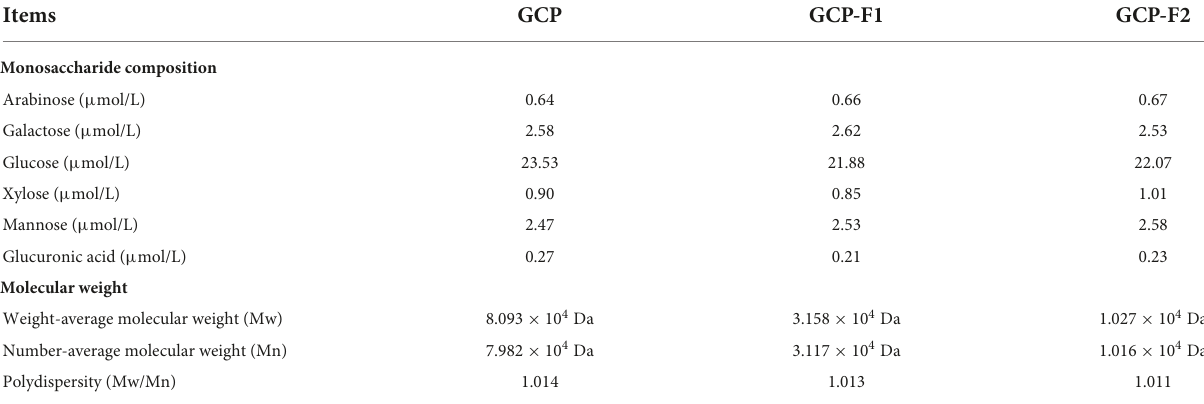
TABLE 1 Monosaccharide compositions and molecular weights of Genistein Combined Polysaccharide (GCP), GCP-F1, and GCP-F2. Items